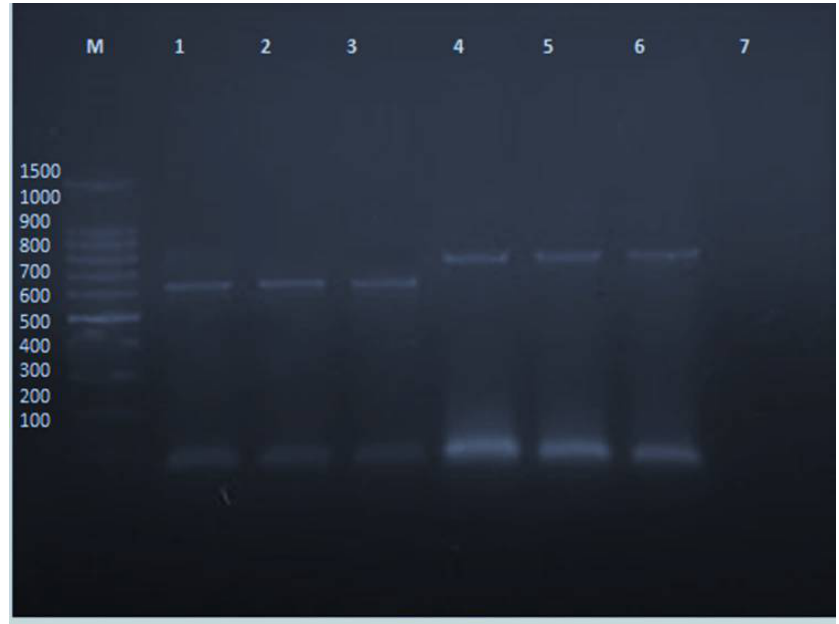
Figure 7. PCR analysis using 1.7% Agarose gel electrophoresis showing the amplified fragment of Potato virus Y (PVY) coat protein gene from potato tissues. Specific PVY cDNA band 825 bp by using specific PVY primers. Lanes 1, 2 and 3 (PLRV) while Lanes 4, 5 and 6 PVY infected potato samples and Lane 7 is healthy potato sample. Lane M is the marker (Biometric) 100 bp DNA Ladder, the size of the cDNA fragment is indicated on the presence of PVY at 825 bp.